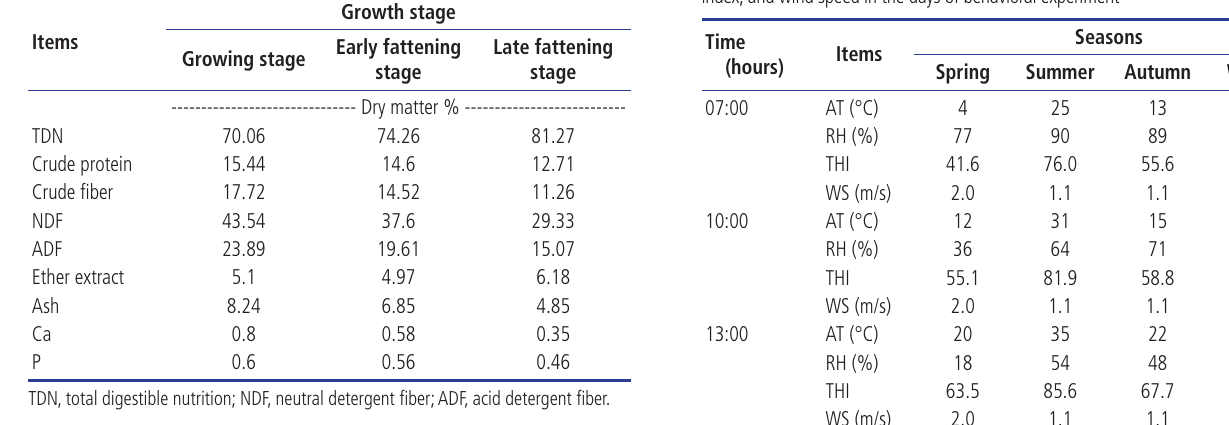
Table 2. The range of ambient temperature, relative humidity, temperature-humidity index, and wind speed in the days of behavioral experiment Time Items (hours)